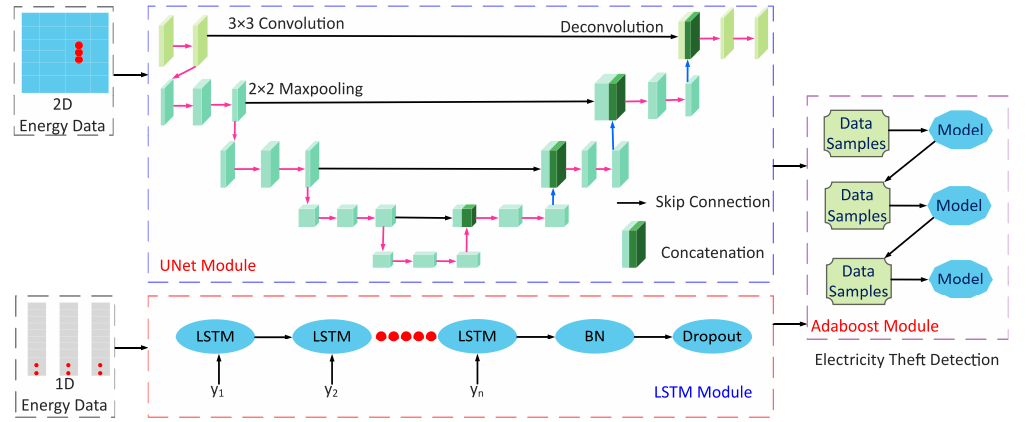
Figure 5. Overview of the proposed LSTM–UNet–Adaboost